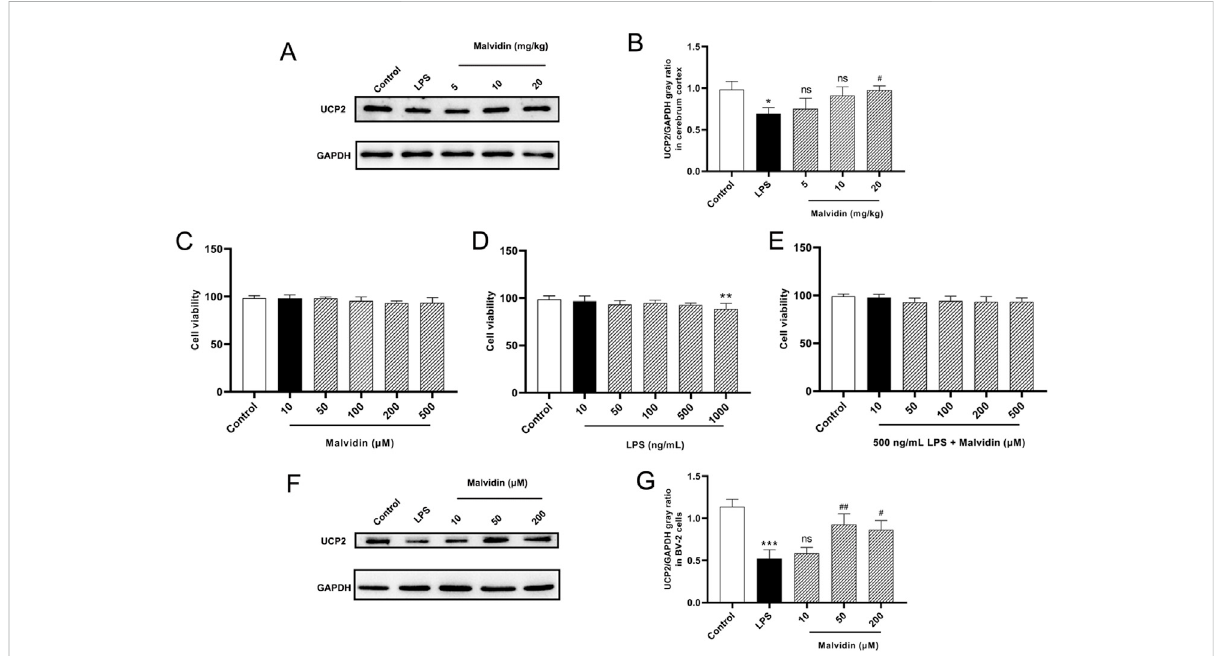
FIGURE 3 Malvidin enhanced UCP2 protein expression in SAE mice cerebrum and LPS stimulated BV-2 cells. (A) UCP2 protein expression levels in the cerebrum tissues were detected using immunoblotting assays. GAPDH was used as an internal reference. (B) Gray ratio analysis of UCP2/GAPDH in (A) usingImageJandexcelsoftware( n =3). (C) Cellviabilitydetermination ofBV-2afterstimulationwithmalvidin(10,50,100,200,500 μ M)for24 h usingCCK8assays. (D) Cellviability determination ofBV-2after stimulation withLPS(10,50,100, 500,1000 ng/ml)for 24 husingCCK8assays. (E) Cell viability determination of BV-2 after co-stimulation with 500 ng/ml LPS and malvidin (10, 50, 100, 200, 500 μ M) for 24 h using CCK8 assays. (F) Immunoblotting assays detection ofUCP2proteinexpressionlevelsintheBV-2cellsincubatedwithorwithout malvidin (50,100, 200 μ M)for 1 h followed by stimulation with 500 ng/ml LPS for 24 h. (G) Gray ratio analysis of UCP2/GAPDH in (F) using ImageJ and excel software ( n = 3). * represents comparison between LPS group and control group, whereas # indicates analysis among LPS group and malvidin pretreatment groups. */# is p < 0.05, **/## is p < 0.01, ***/### is p < 0.001, and ns is p >